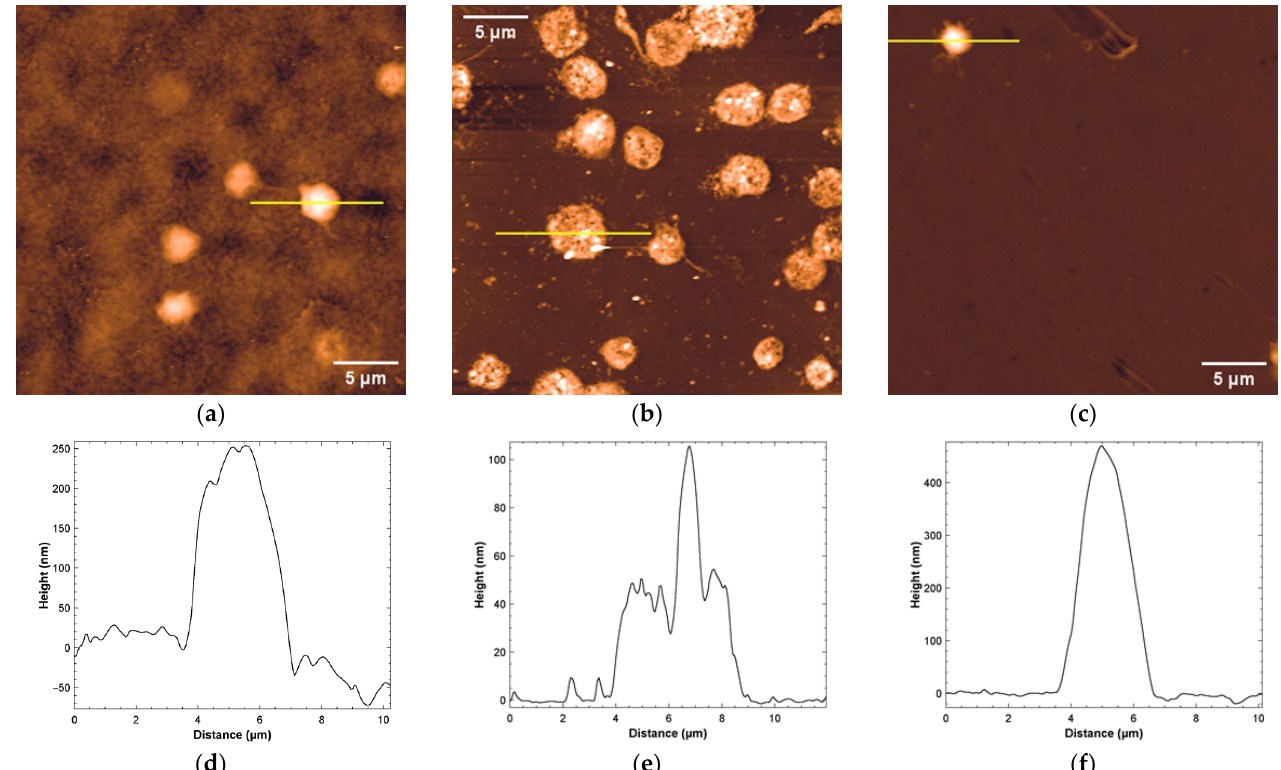
Figure 6. Representative AFM analysis of platelets adherent to: ( a ) PMMA (z false-color scale from − 50 to 250 nm), ( b ) NOA81 (z false-color scale from − 10 to 80 nm), and ( c ) COC (z false-color scale: − 50 to 450 nm). The height profiles traced along the yellow lines are shown respectively in ( d – f ).